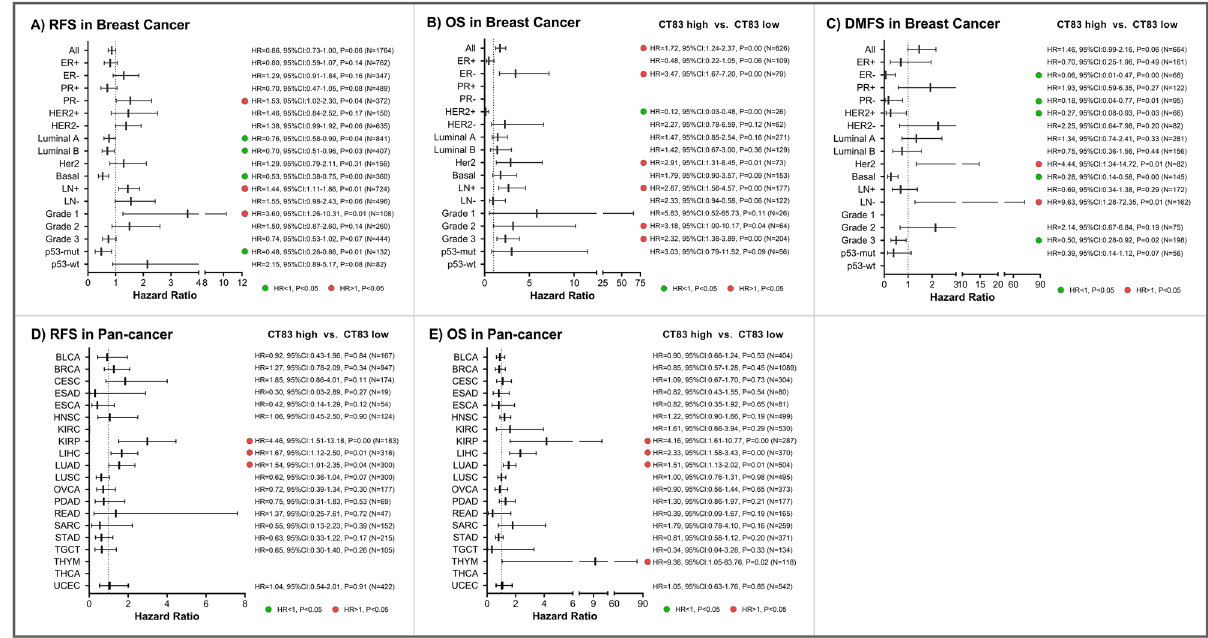
Figure 7. Prognostic significance of CT83 in breast cancer and pan-cancer. The hazard ratios of CT83 (high vs. low) for ( A ) RFS, ( B ) OS, and ( C ) DMFS in breast cancer grouped by different clinical characteristics. The hazard ratios of CT83 (high vs. low) for ( D ) RFS, ( E ) OS in different cancers. Abbreviations: RFS, relapse-free survival; OS, overall survival; DMFS, distant metastases-free survival; HR, hazard ratio; 95%CI, 95% confidence interval; P, log-rank test P -value; see https:// gdc. cancer. gov/ resou rces- tcga- users/ tcga- code- tables/ tcga- study- abbre viati ons for TCGA study abbreviations.